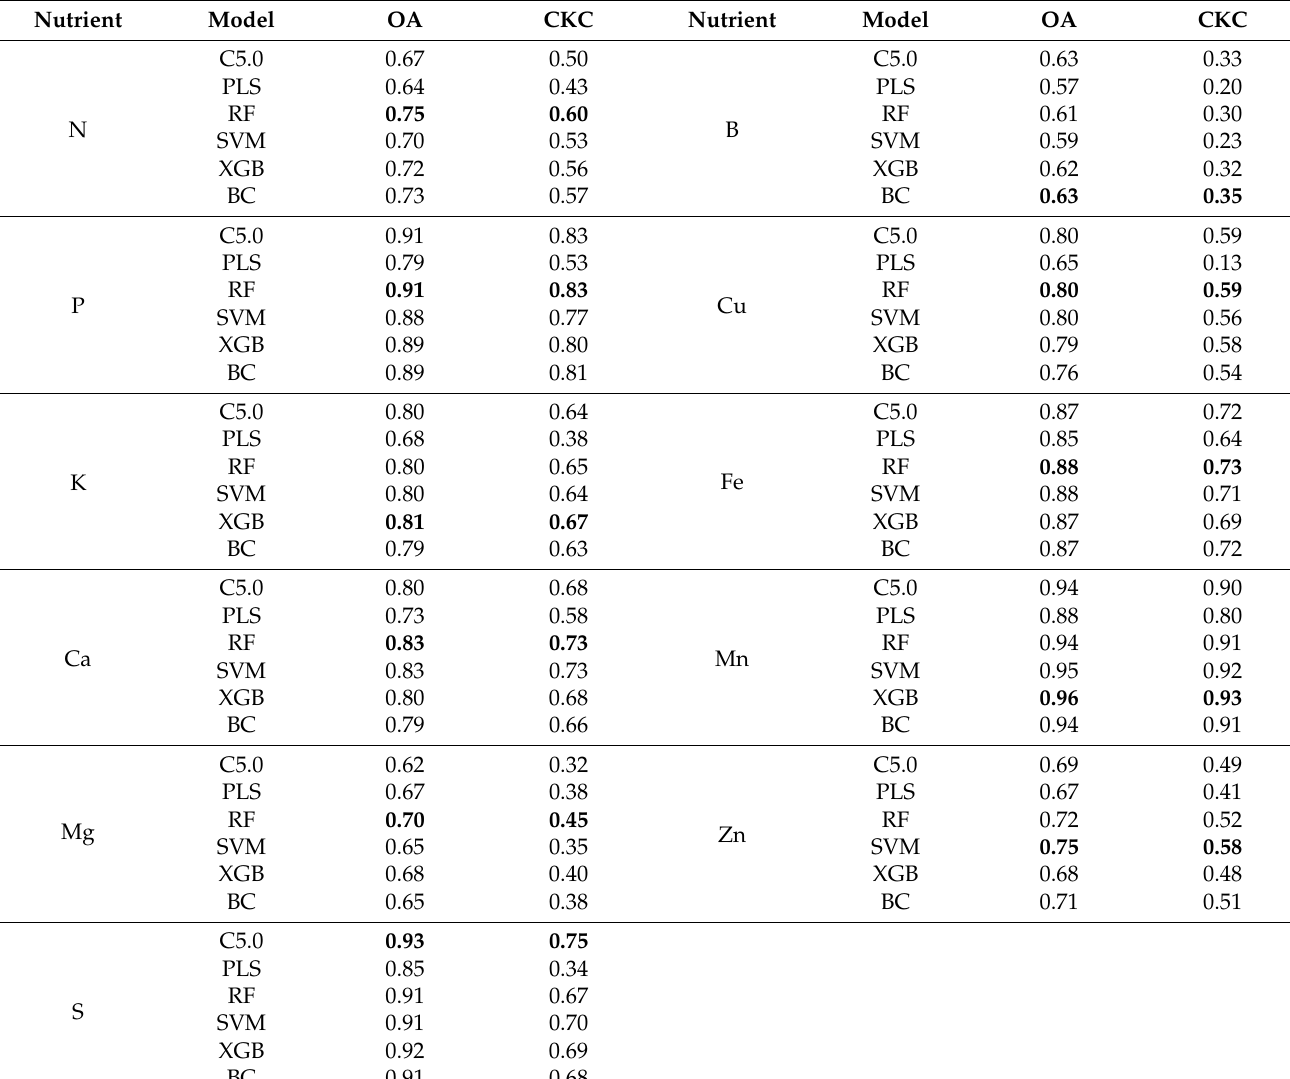
Table 4. Overall accuracy (OA) and Cohen’s Kappa coefficient (CKC) for macro and